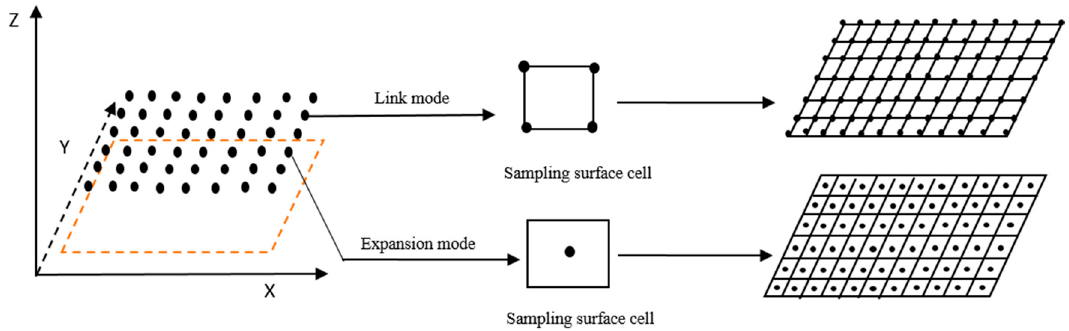
Figure 4. Spatial lattice model for projection surface space.